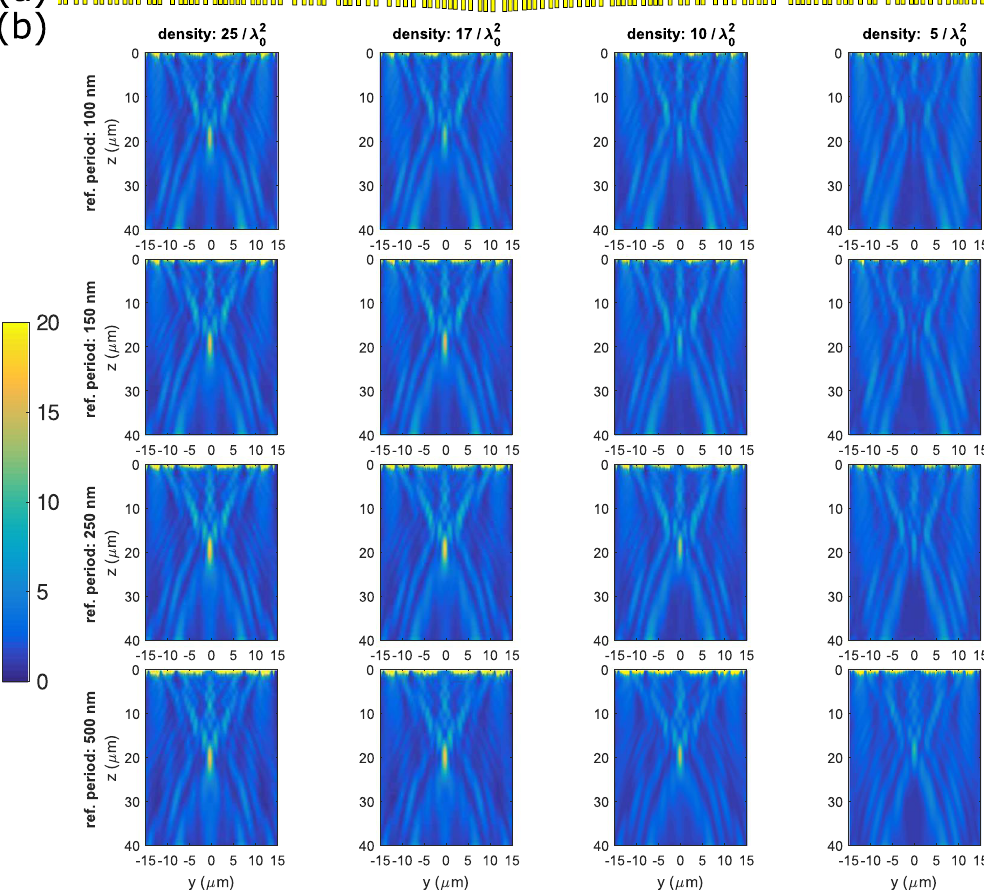
Figure 3. ( a ) Example of 1D random metasurface realization for the highest density in the plane z = 0. ( b ) Average of the density of energy over 10 samples of 1D random metasurfaces. Density of energy of the reflected field normalized by the density of energy of the incident field plotted in the yz plane for 16 one-dimensional random metalenses at 200 THz ( λ = 1.5 μ m) corresponding to four different periods of the reference times four different but equivalent densities of the random metasurface. The considered densities are 25, 17, 10, 5 λ 0 − 2 , and they correspond to periods p y in the periodic system of 100 nm, 150 nm, 250 nm, and 500